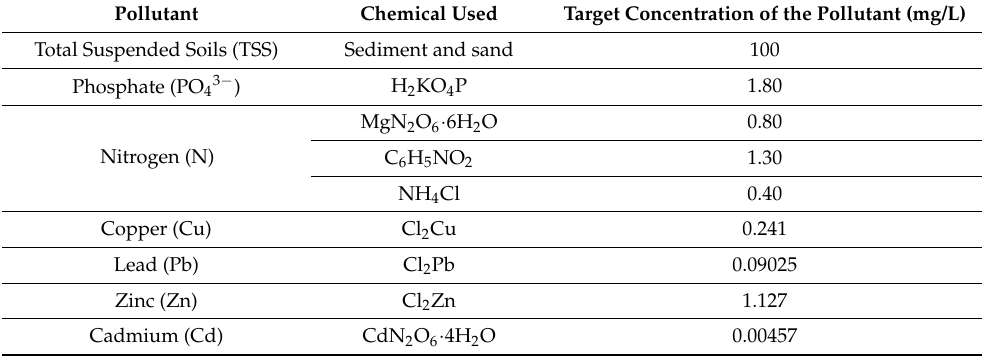
Table A2. Characteristics of simulated water.